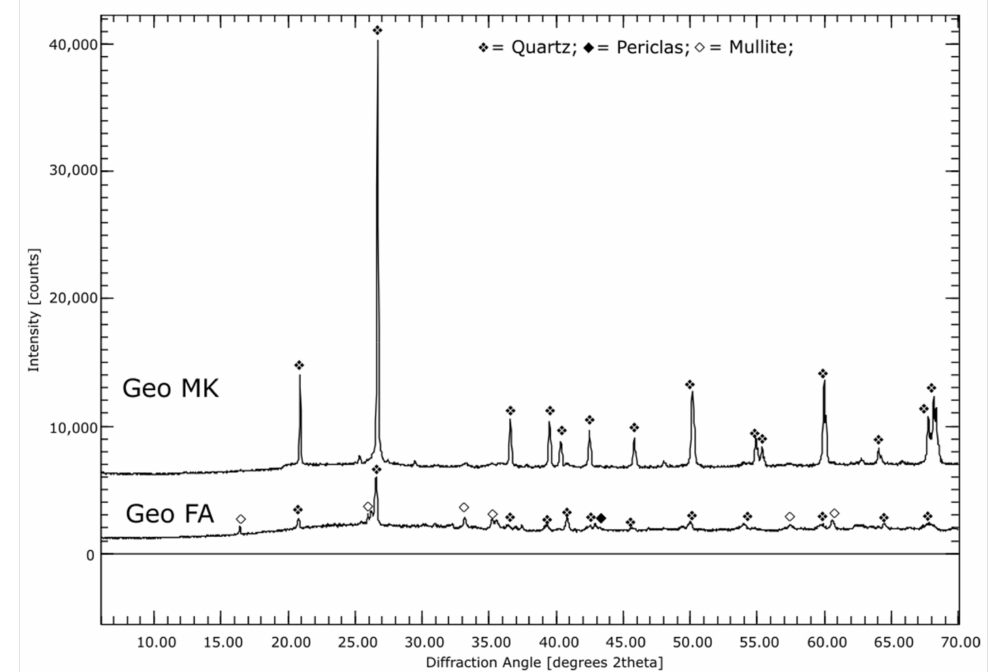
Figure A4. Graphical representation of XRD measurements: